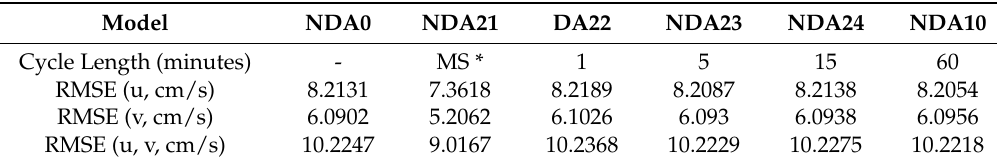
Table 2. Nudging Cycle Length Test Models (+12 h